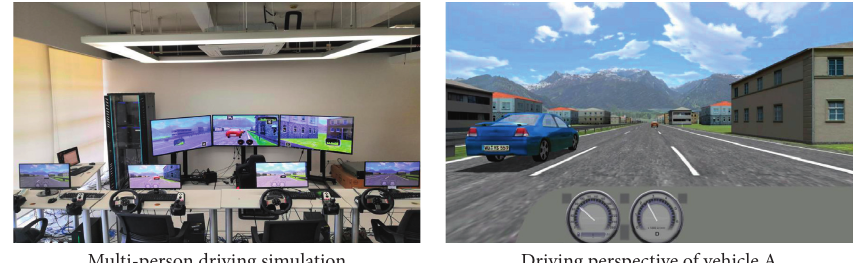
Figure 11: Multivehicle simulation driving experiment. (a) Multipurpose driving simulation. (b) Driving perspective of vehicle